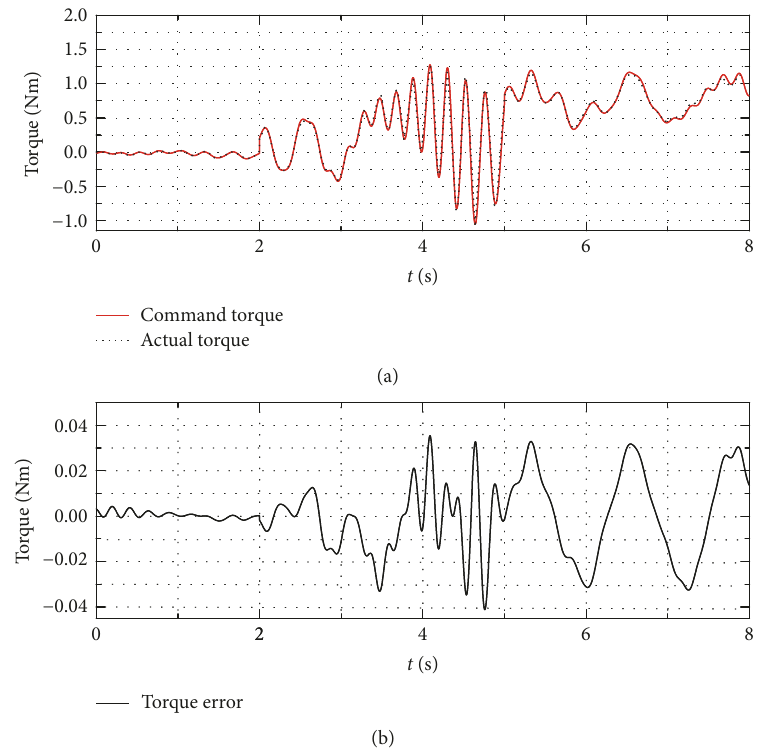
Figure 6: Comparison between the command load torque and the actual load torque. Table 2: Root mean square error for di ff erent load sti ff ness values. Ma=0.4 Data group